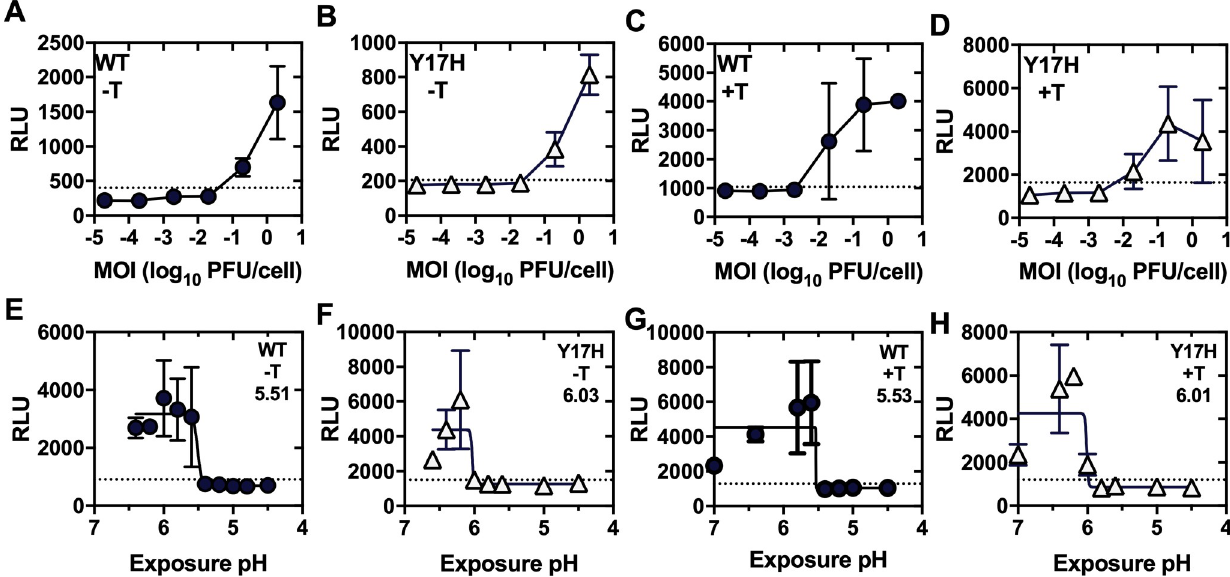
Fig 2. Renilla luciferase assay of residual infectivity after acid exposure using MDCK Luc9.1 reporter cells. MDCK Luc9.1 cells were inoculated with A/ TN/09 WT (solid circles) or Y17H (open triangles) at MOI values ranging from 2x10 -5 to 2 PFU/cell and were overlaid with media lacking TPCK-treated trypsin (A,B; -T) or containing it (C,D; +T). After 17 h, cell lysates were mixed with Renilla luciferase substrate and luminescence (relative light units, RLU) was measured using a 96-well plate luminometer. Virus aliquots in panels E-H were exposed to pH-adjusted PBS for 1h before inoculation into Luc9.1 reporter cells at an MOI of 2 (E,F) or 0.2 (G,H) PFU/cell. Data in panels E-H were fit by nonlinear regression (dose-response simulation) to calculate the midpoints of inactivation, or “inactivation pH”, which are listed on the panels. Dotted horizontal lines correspond to the lowest detectable residual infectivity after acid treatment (defined as 3 standard deviations above the mean of low-pH inactivated aliquots). Error bars represent standard deviation (n = 3). Reported data are representative of three independent experiments.